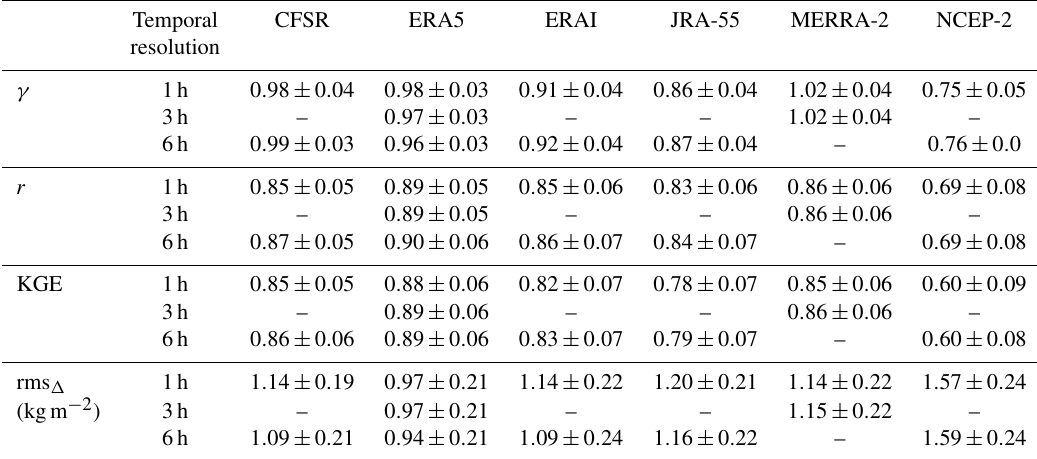
Table 2. Statistics of the consistencies in diurnal IWV anomalies from reanalyses compared to GPS. Temporal